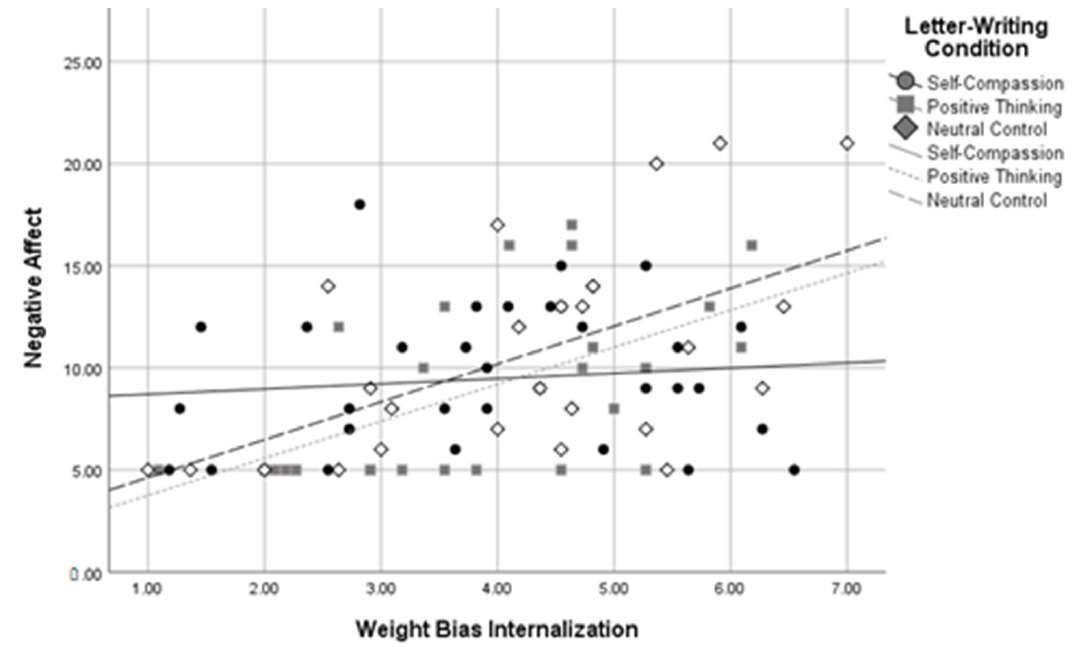
Figure 7. Le tt er-Writing Condition*Weight Bias Internalization Interaction on Negative A ff ect. Figure 7. Letter-Writing Condition*Weight Bias Internalization Interaction on Negative